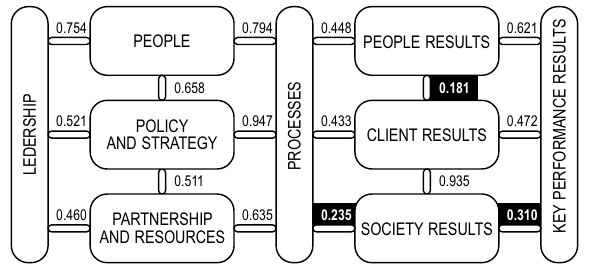
Fig. 5. Correlation coefficients for the investors